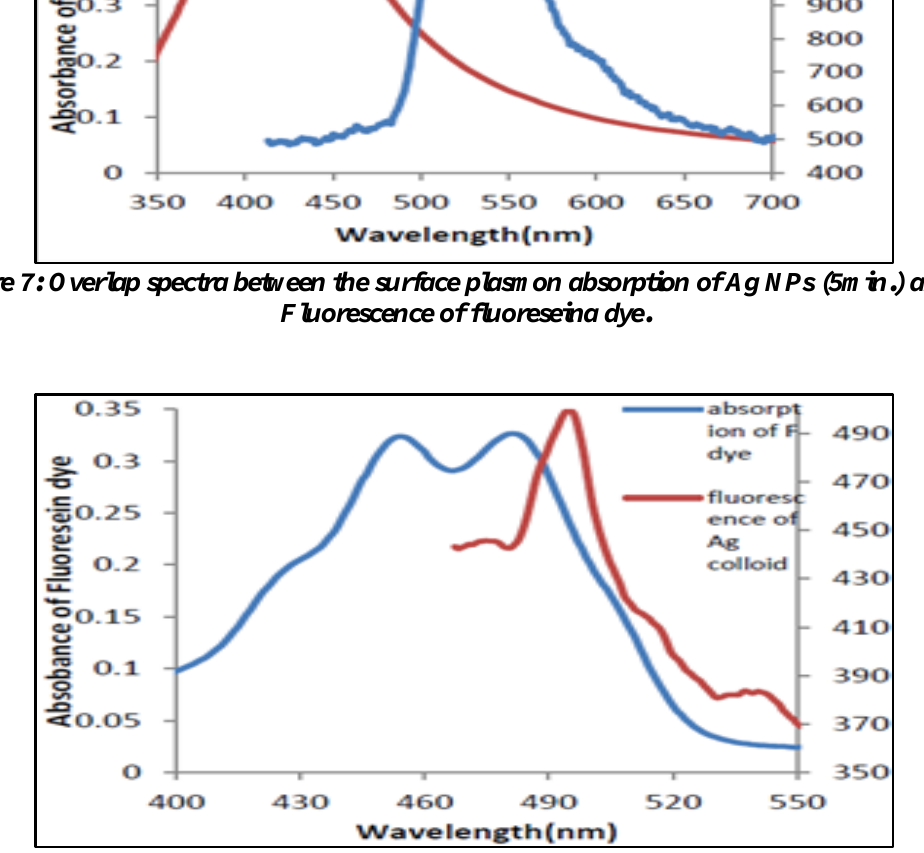
Figure 8: Overlap spectra between the absorption of fluoreseina dye and the fluorescence of Ag NPs (5 min.).